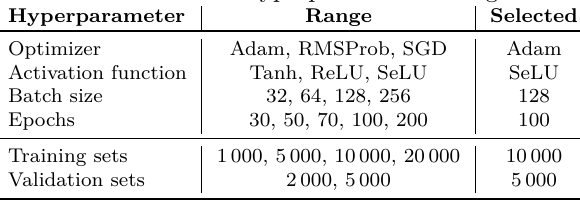
Table 1: CAE hyperparameter